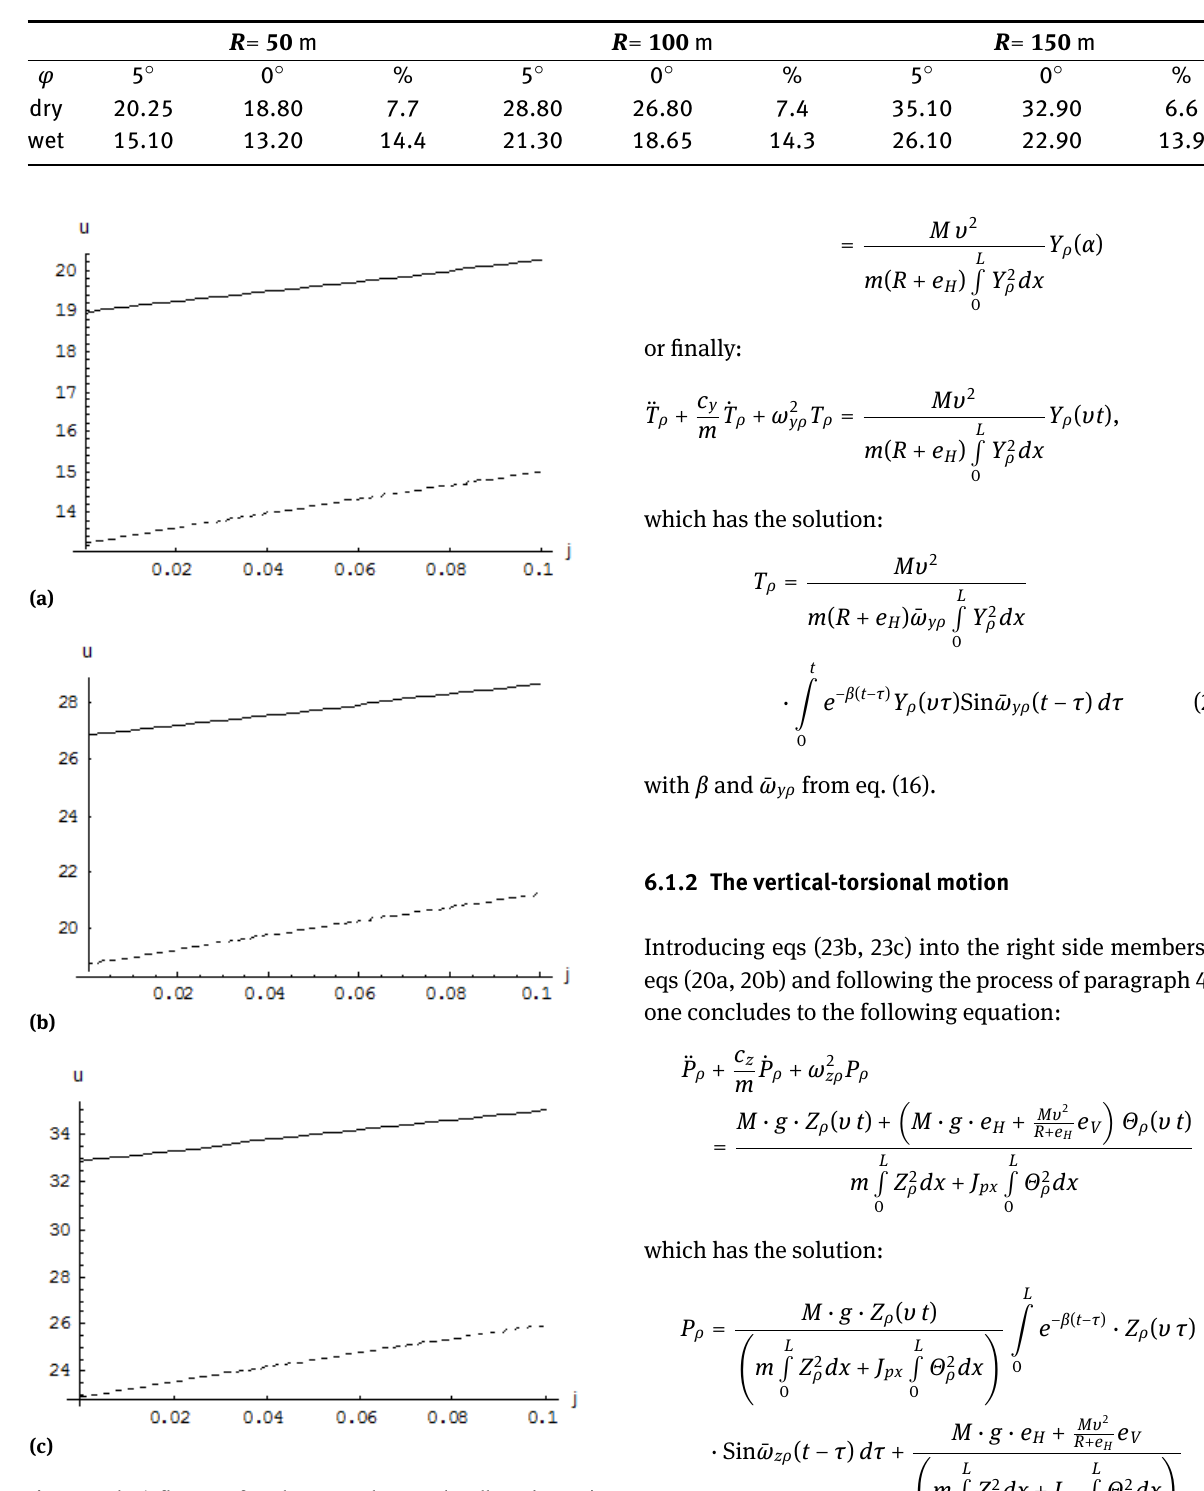
Figure 3: The influence of track cant angle φ on the allowed speed υ for various R